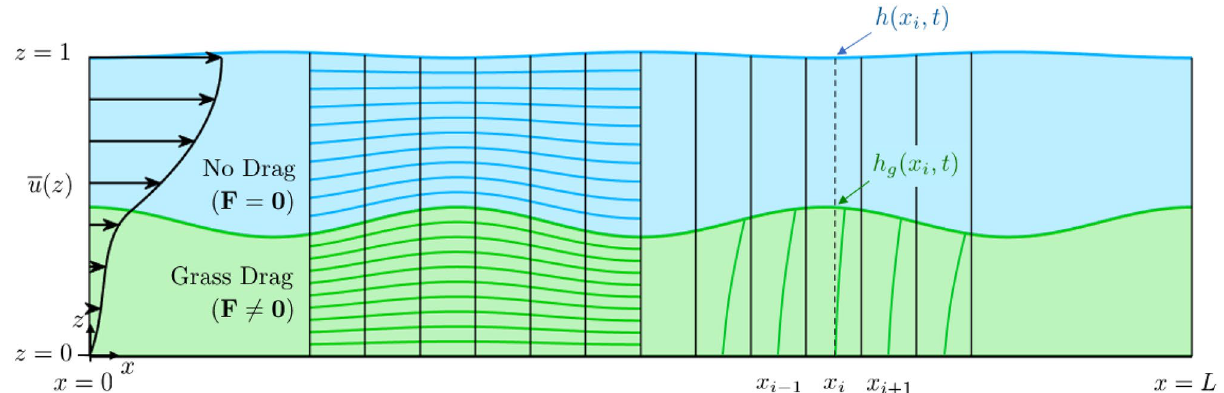
Figure 1. Schematic of the domain used in the simulations. The steady-state horizontal velocity profile u ( z ) is imposed as the velocity inlet boundary condition. A conformal map accounts for variations in h and h g to separate the overflow (where F = 0 , in blue) and seagrass (where F = 0 , in green) regions of the domain. Buoyant grass blades deform by the flow, apply a drag F on the fluid, and the composite tip positions determine h g